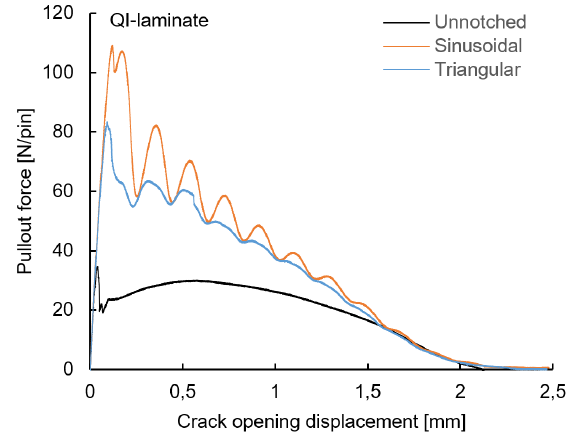
Figure 4. Representative z-pin pullout curves of unnotched and circumferentially notched z-pins with different notch designs in quasi-isotropic laminates.